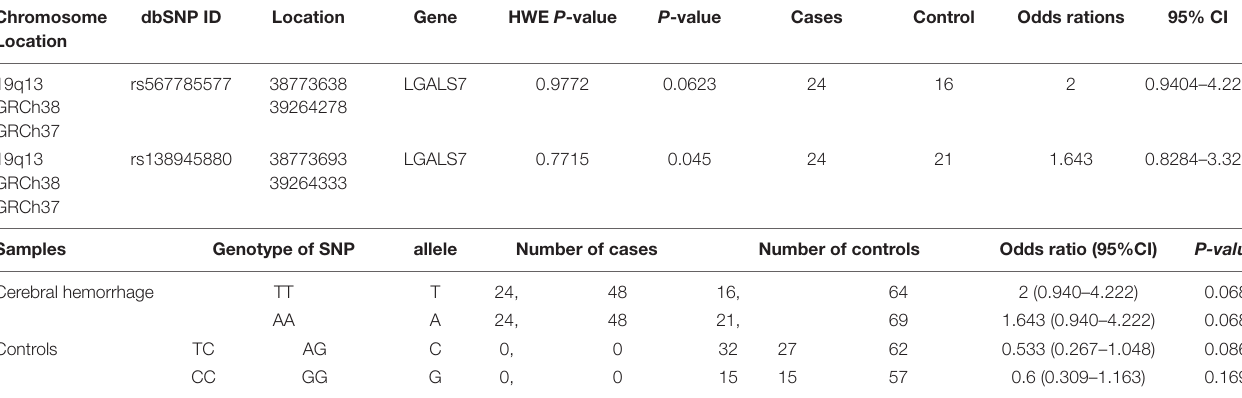
TABLE 4 | Polymorphic analysis and statistical analysis of the promoter of galectin-7 genotypes. Chromosome